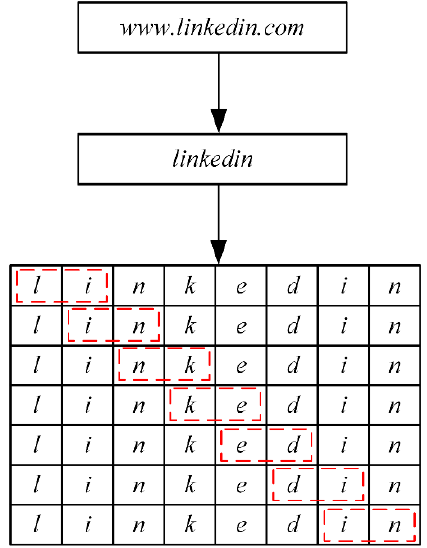
Figure 4. N-gram ( N = 2) algorithm to process “ linkedin.com ”.